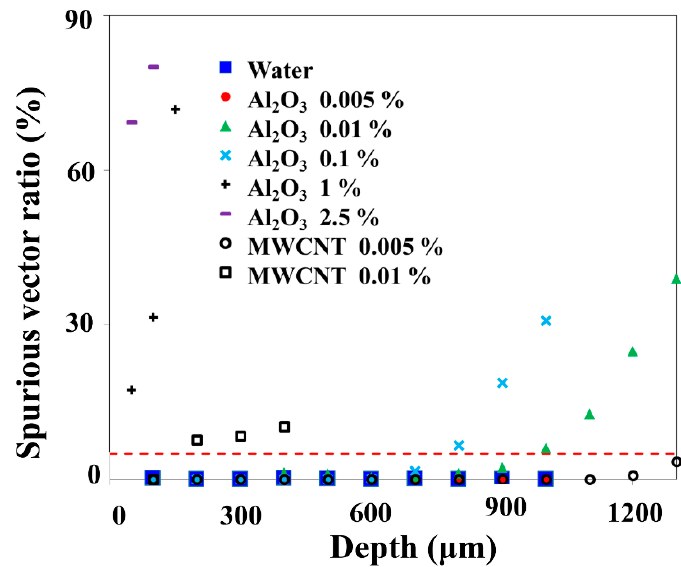
Figure 5. Variations of spurious vector ratios obtained by particle images at different focal plane depths. The total number of vectors is 2,025 and the red dotted line indicates a 5% ratio.